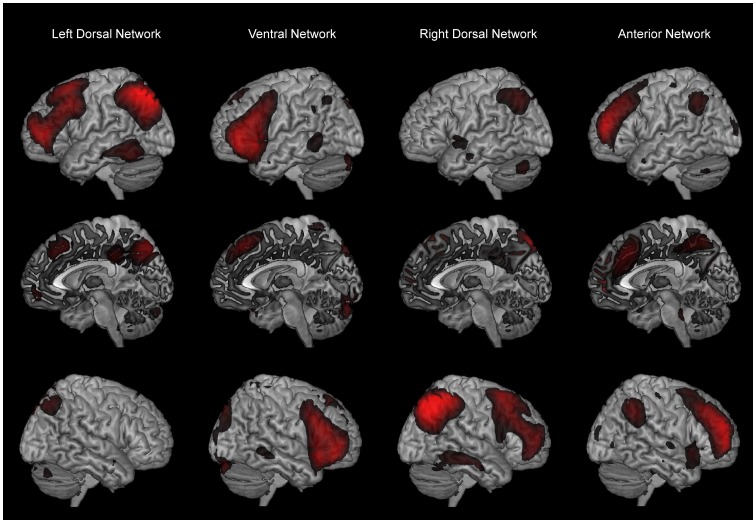
Spatial maps of independent components.Depicted in left, medial and right view are the four independent components selected for further statistical analysis: left dorsal; ventral; right dorsal; anterior network.